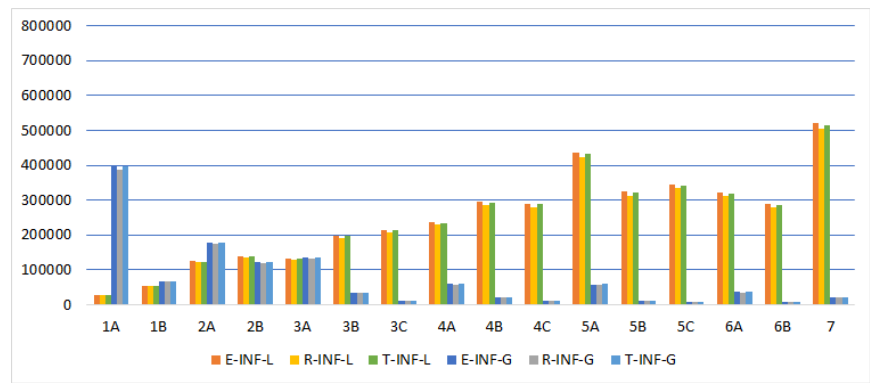
Fig. 5. Comparison of heat gains and losses from infiltration in 3 models